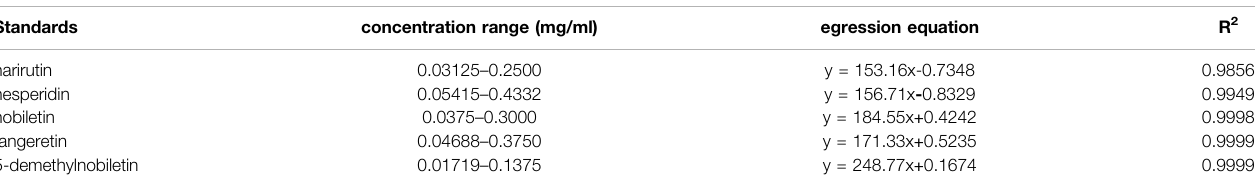
TABLE 2 | The regression equations of fl avonoid